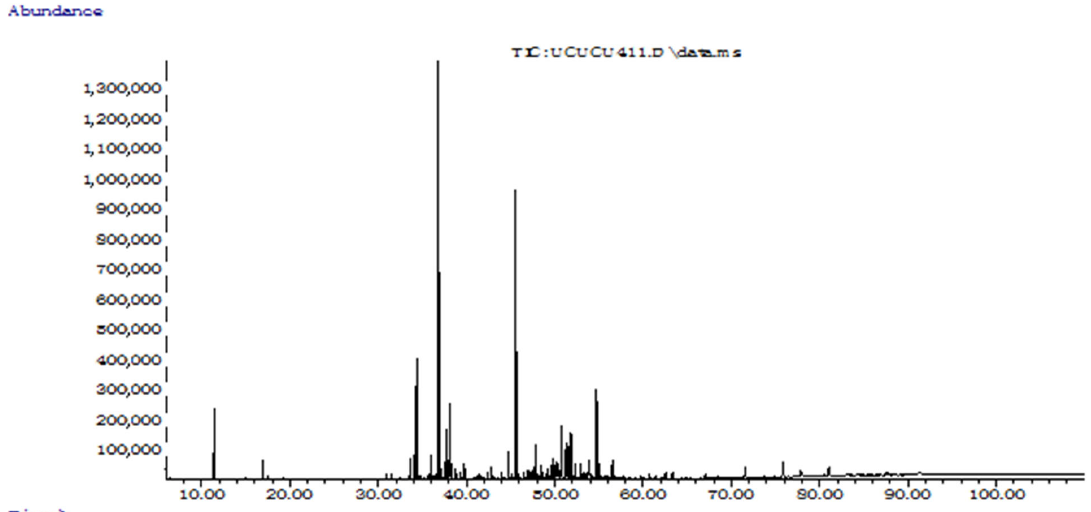
Figure 3. Total ion chromatogram of essential oil from aerial part of Lavandula stricta.